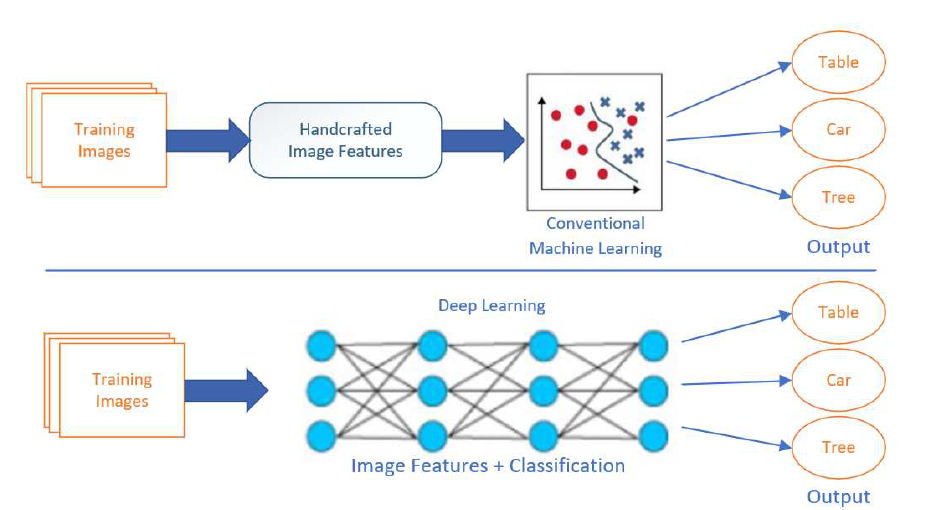
Figure 1. Two approaches for object classification: Conventional ML and DL